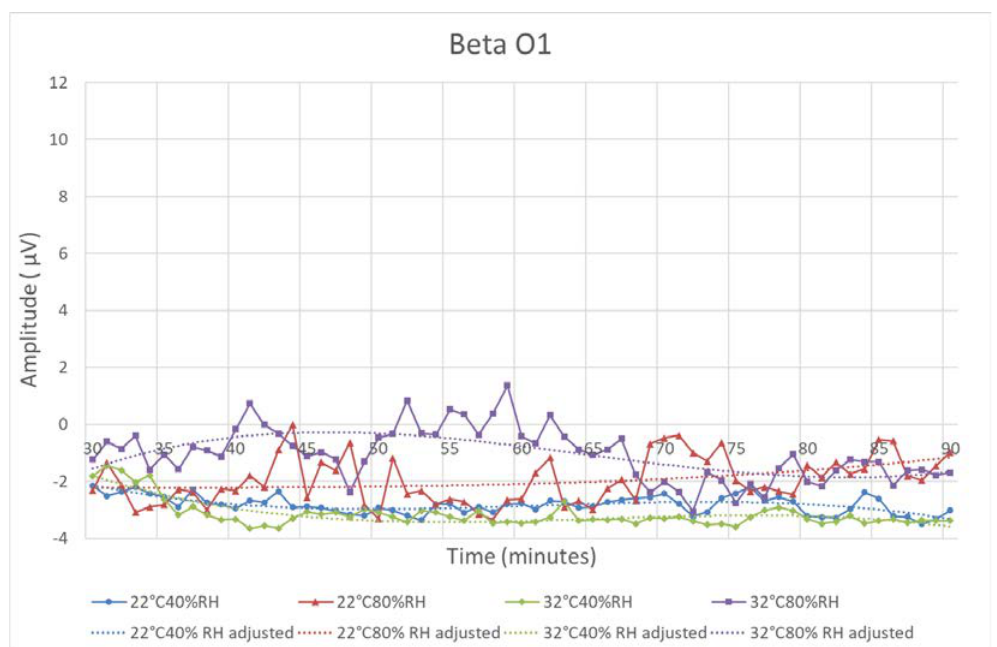
Figure 7. Mean values of Beta O1 waves from the 15 volunteers at different temperatures